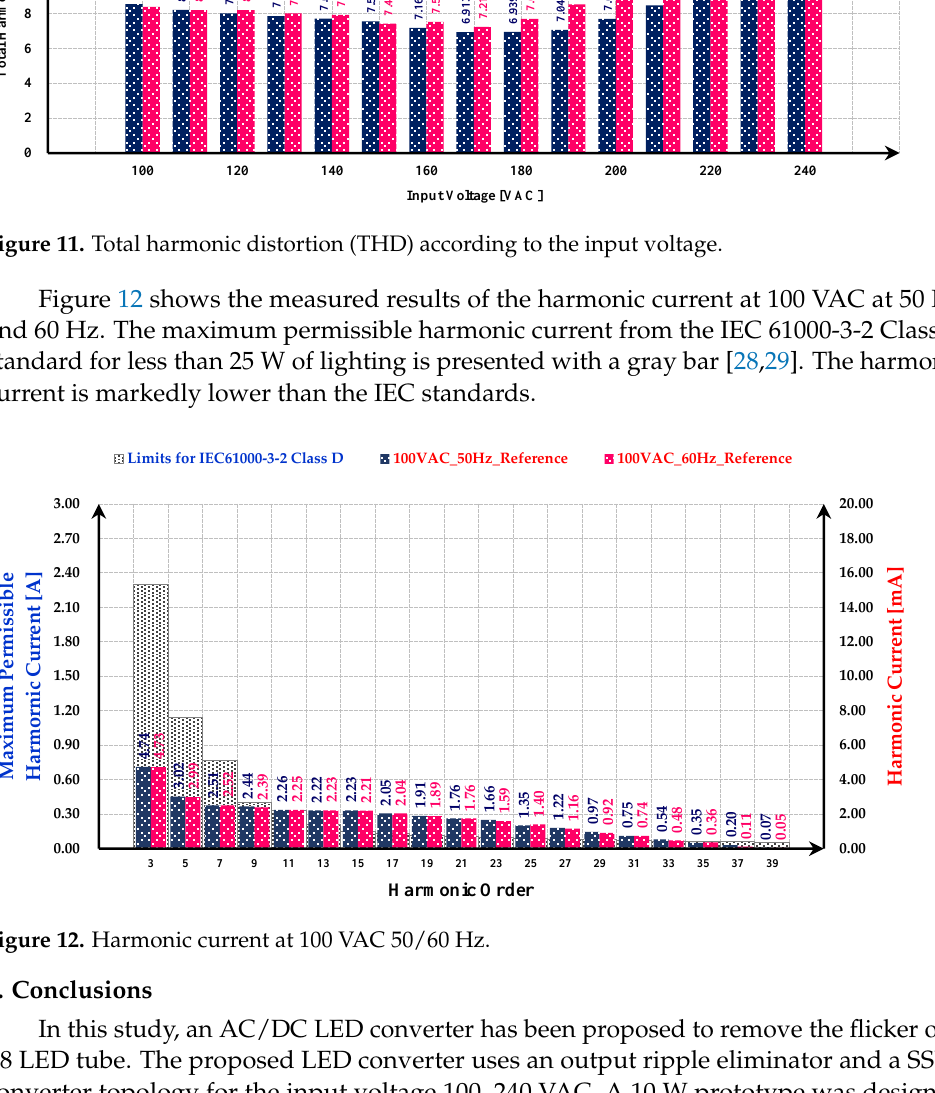
Figure 12. Harmonic current at 100 VAC 50/60 Hz.